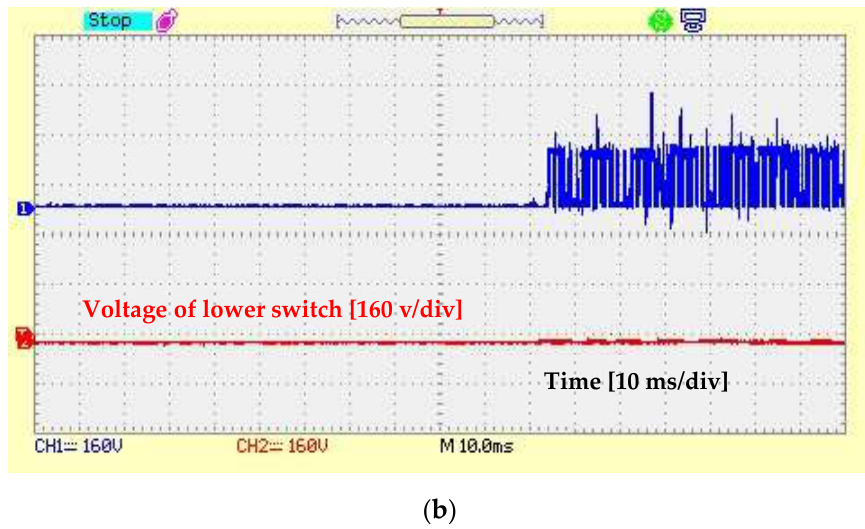
Figure 19. Performance measures of the proposed topology when reconfiguring from HERIC to H5; ( a ) output voltage and load current, and ( b ) voltage stresses of the reserve switches.